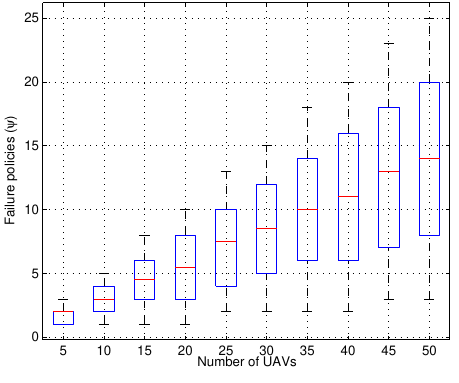
Figure 6. Induced failure policies vs. number of